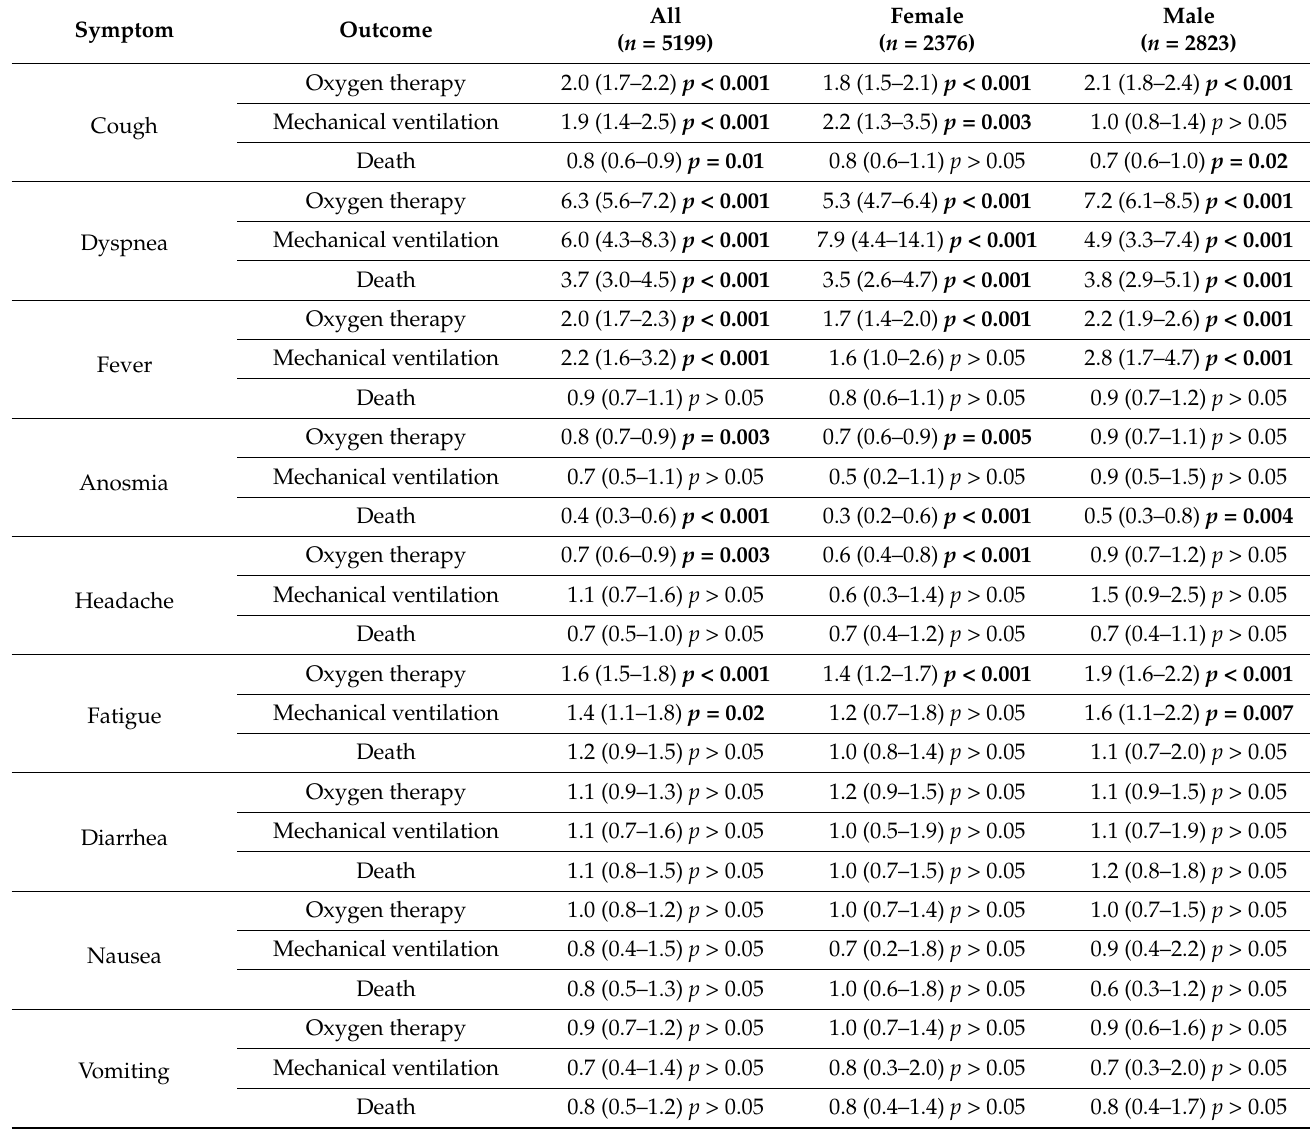
Table 2. The odds ratio (95% confidence interval) for mechanical ventilation and death in relation to different early COVID-19 symptoms presented by hospitalized